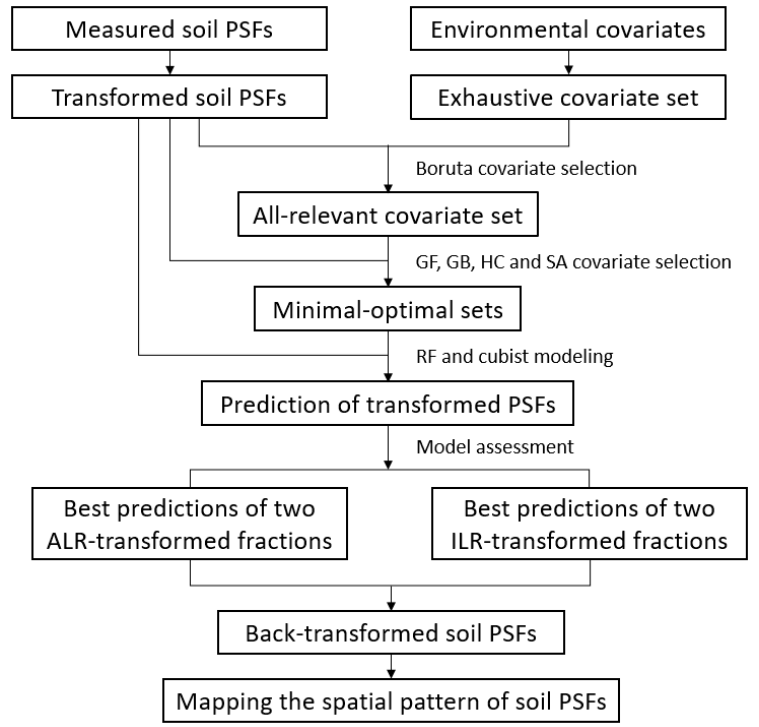
Figure 2. Flowchart of the methodology used in this study.